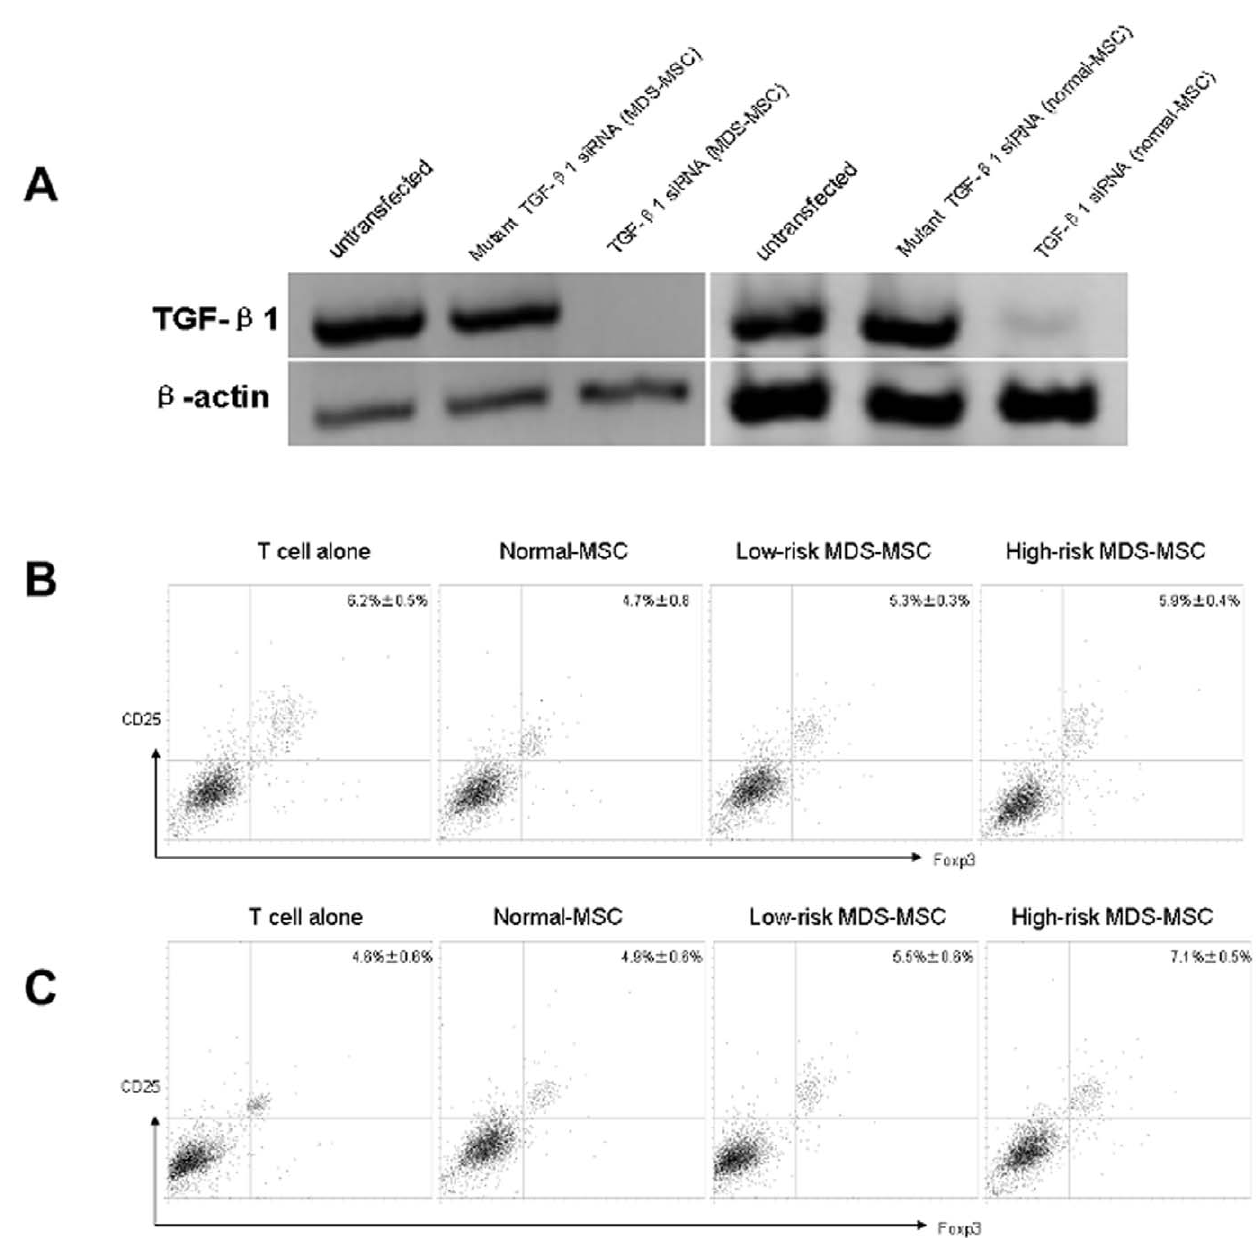
Figure 5. Induction of CD4 + CD25 + Foxp3 + Tregs by MDS-MSC is dependent on TGF b 1. Western blot confirmed efficient knockdown of TGF- b 1. (B) CD4 + CD25-T cells were cultured with TGF- b 1 knockdown MDS-MSC or normal-MSC for 5 days, and CD4 + T cells were collected. The expression of CD25 and Foxp3 on CD4 + T cells was analyzed by FACS. Results are expressed as mean 6 SD of triplicates of 5 separate experiments. *P # 0.05. (C) CD4 + CD25-T cells were cultured with mutant siRNA transfected MDS-MSC or normal-MSC for 5 days, and CD4 + T cells were collected. The expression of CD25 and Foxp3 on CD4 + T cells was analyzed by FACS. Results are expressed as mean 6 SD of triplicates of 6 separate experiments. *P # 0.05. (D) anti-rhTGF- b 1 mAb was added at the beginning of coculture of CD4 + CD25-T cells and untransfected MDS-MSC or normal-MSC for 5 days, and CD4 + T cells were collected. The expression of CD25 and Foxp3 on CD4 + T cells was analyzed by FACS. Results are expressed as mean 6 SD of triplicates of 6 separate experiments. *P #